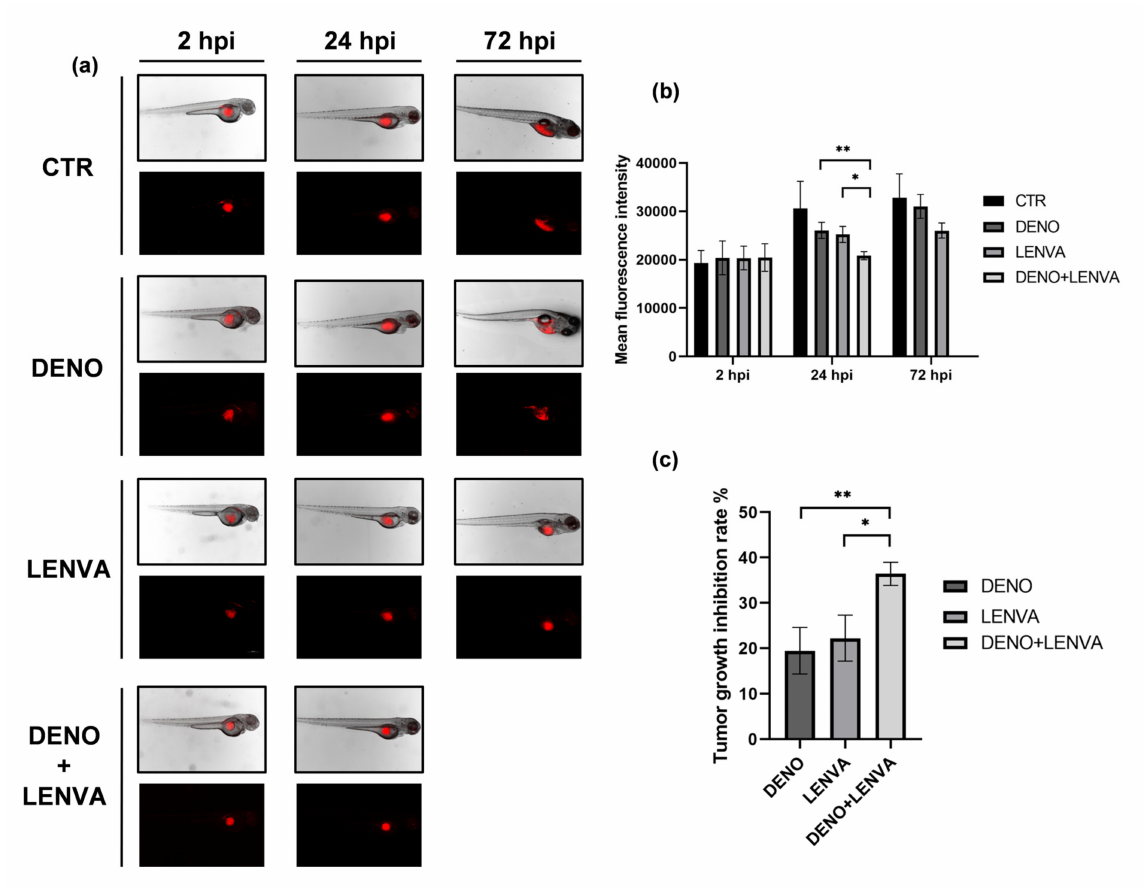
Figure 5. ( a ) Representative fluorescence microscopy images of zebrafish embryos xenotransplanted with DF1. Images of embryos untreated and exposed to DENO, LENVA and DENO + LENVA at 2, 48 and 72 hpi, scale bar 1000 µ m. ( b ) Mean fluorescence signal of DF1 xenotransplanted embryos, arbitrary units. ( c ) Tumor-growth inhibition rate between tested drugs. Significant differences among treatments were accepted for p < 0.05 (*) and p < 0.001